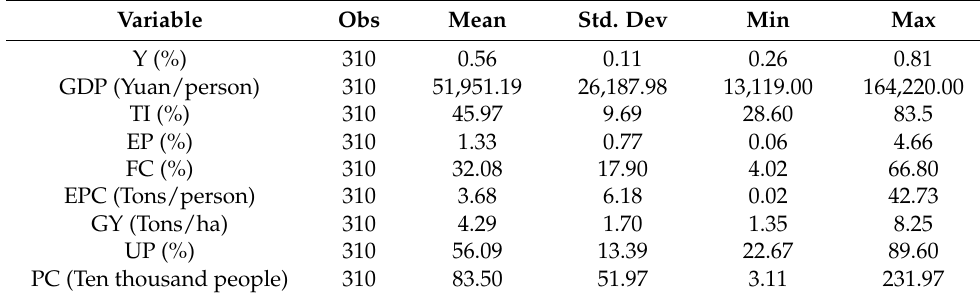
Table 5. Descriptive Statistics of